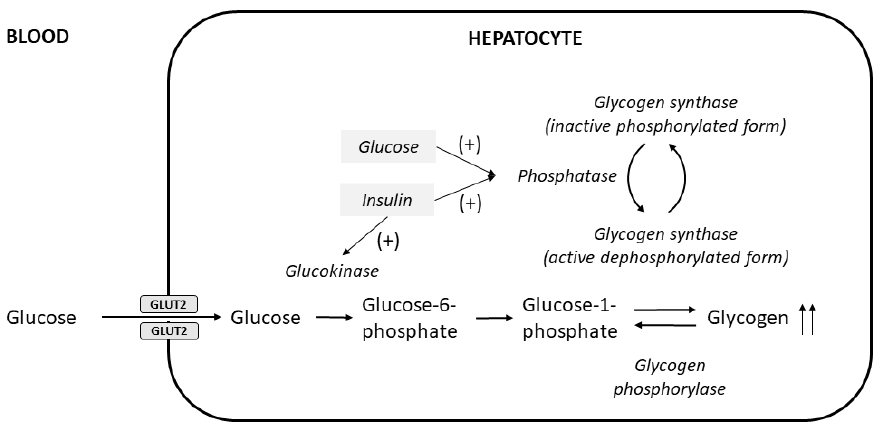
Figure 2. Pathogenesis of hepatocellular glycogen accumulation in the liver, highlighting the role of both elevated glucose levels and insulin treatment in glycogenic hepatopathy (modified from Munns et al. [26]). Glucose enters hepatocytes via facilitated diffusion through glucose transporter 2 (GLUT2) independent of insulin, where it is then phosphorylated to glucose-6-phosphate by glucoki- nase and subsequently converted to glycogen by glycogen synthase. Insulin activates glucokinase, and also acts together with elevated glucose levels to stimulate the phosphatase enzyme to produce the active dephosphorylated form of glycogen synthase